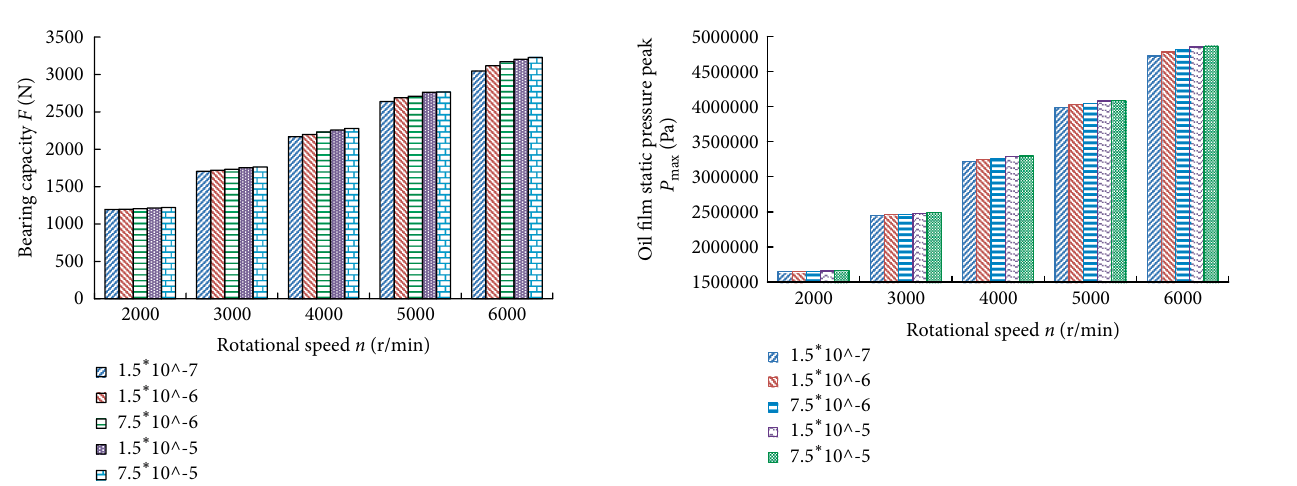
Figure 8: Effect of w and rotational speed on bearing capacity. g